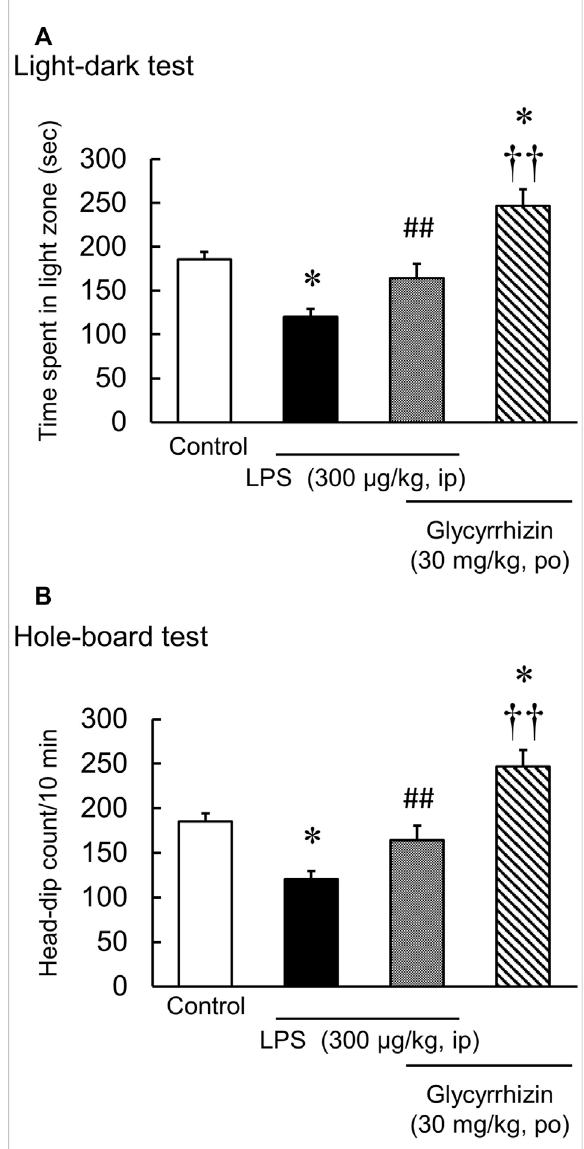
FIGURE 4 Results of the hole-board test and light-dark test conducted after liposaccharide (LPS)-treatment. Preventive effect of glycyrrhizinonthenumberofhead-dipsofhole-boardtest (A) and thetimespentinthelightzoneoflight-darktest (B) incontrol and LPS-treated mice, and mice before LPS-treatment. Data are shown as mean ± SEM; n = 6 per group. *: p < 0.05 (vs. control), †† : p < 0.01 (vs. LPS), ## : p < 0.01 (vs.